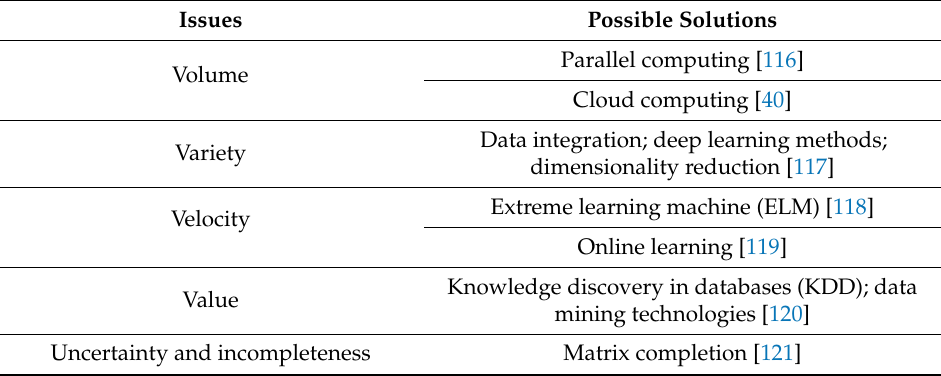
Table 14. Issues and possible solutions of machine learning for big